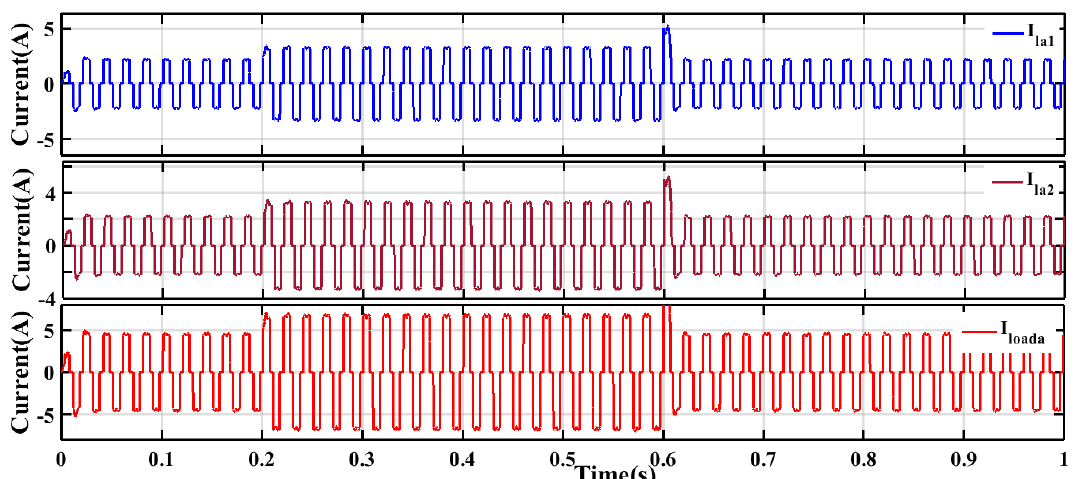
Figure 16. Current sharing during transient load condition.